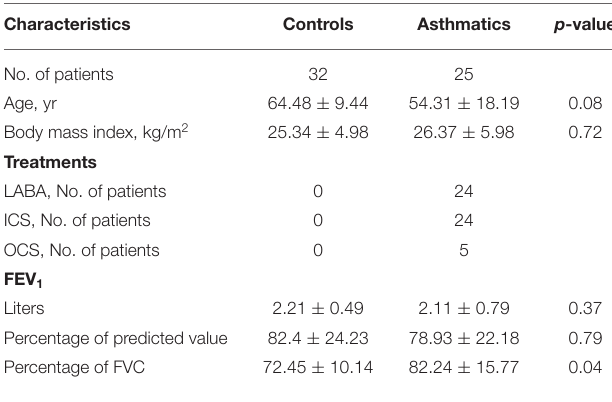
TABLE 1 | Patients’